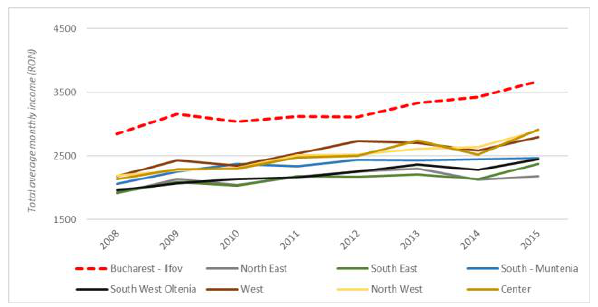
Figure 4 . Evolution of average monthly net income within the 8 development regions between 2008 and 2015 (data source: NIS 2022)